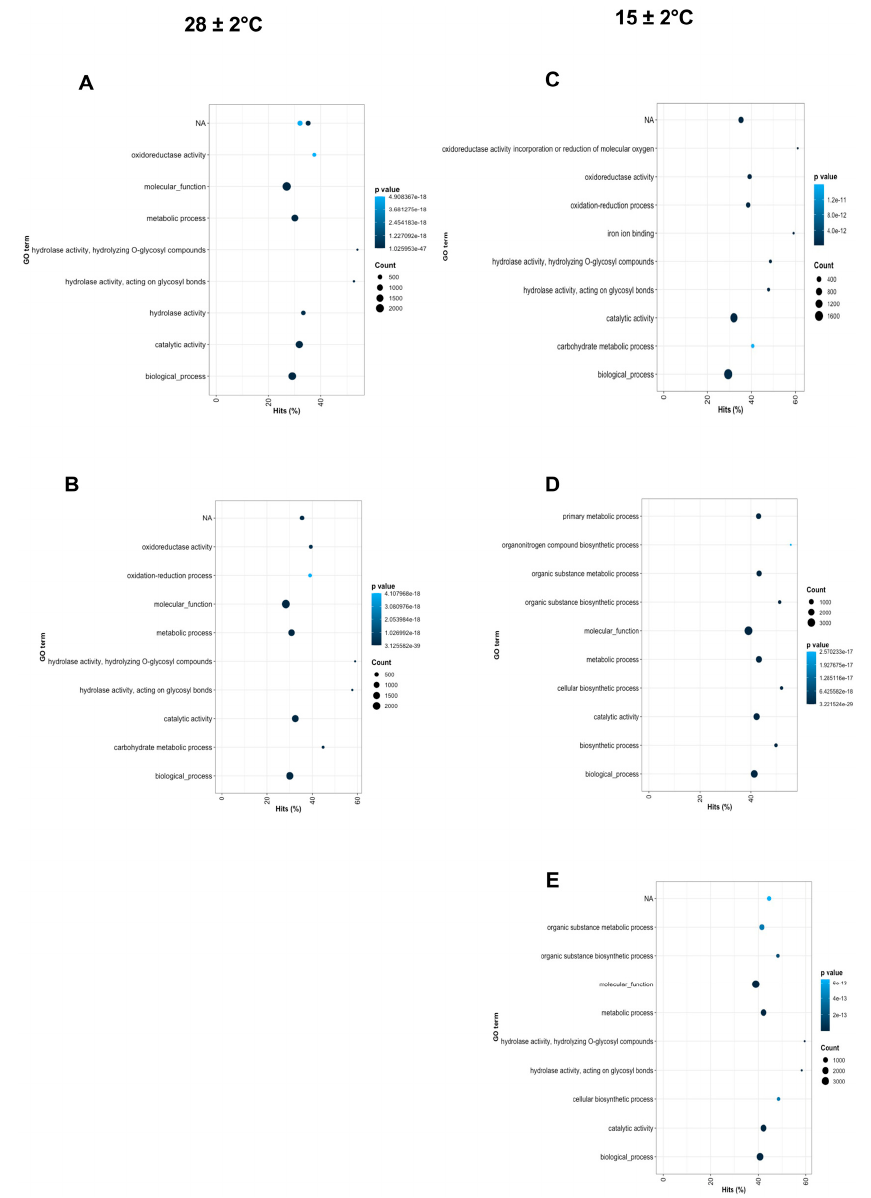
Figure 6. Top 10 significantly enriched GO terms of the DEG by each pairwise comparison against Day 0, ( A ) Day 3 at 28 ± 2 ◦ C, ( B ) Day 6 at 28 ± 2 ◦ C, ( C ) Day 3 at 15 ± 2 ◦ C, ( D ) Day 6 at 15 ± 2 ◦ C, ( E ) Day 9 at 15 ± 2 ◦ C. The y -axis represents the GO terms, and the x -axis represents the percentage hits of enriched genes. The circle size indicates the genes in each GO term. Color scale means adjusted p